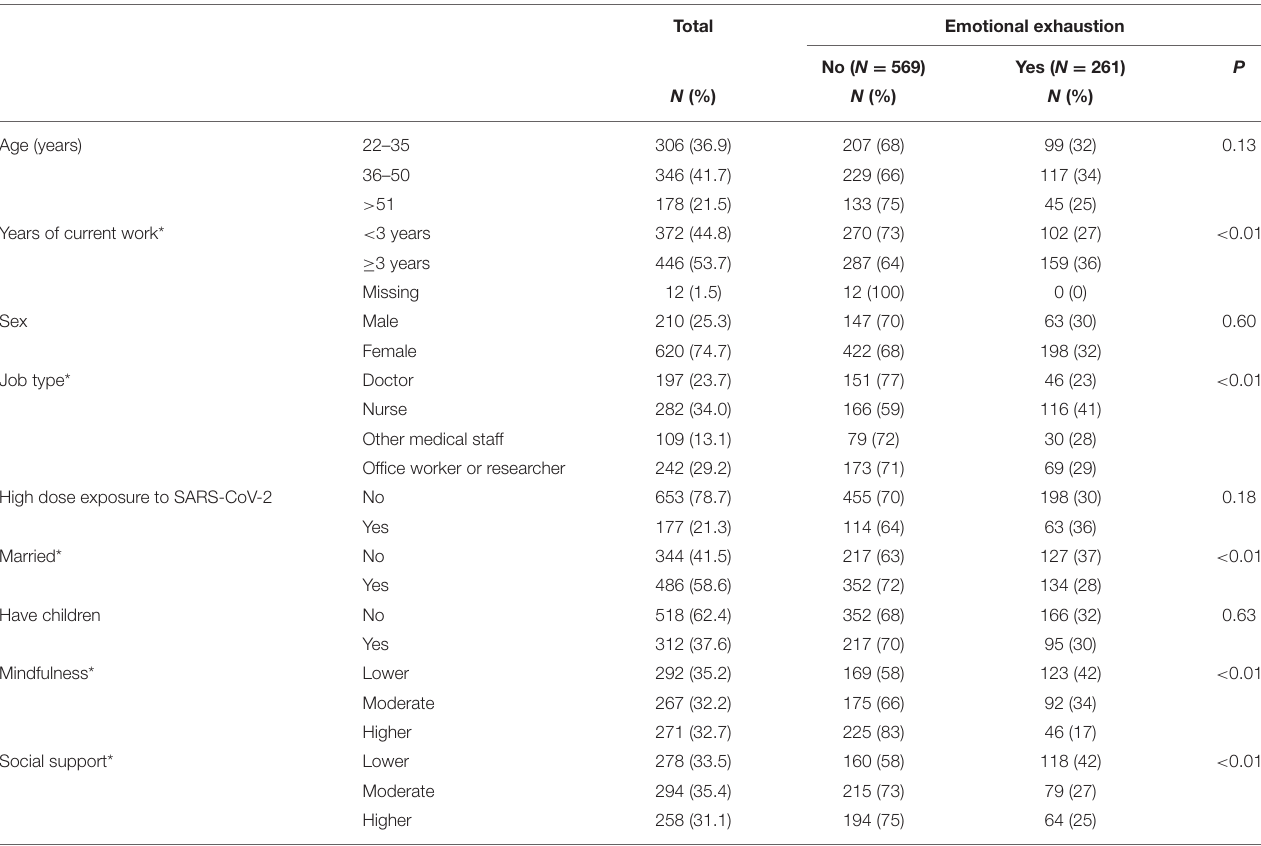
TABLE 1 | Demographic characteristics all of the participants and by emotional exhaustion.